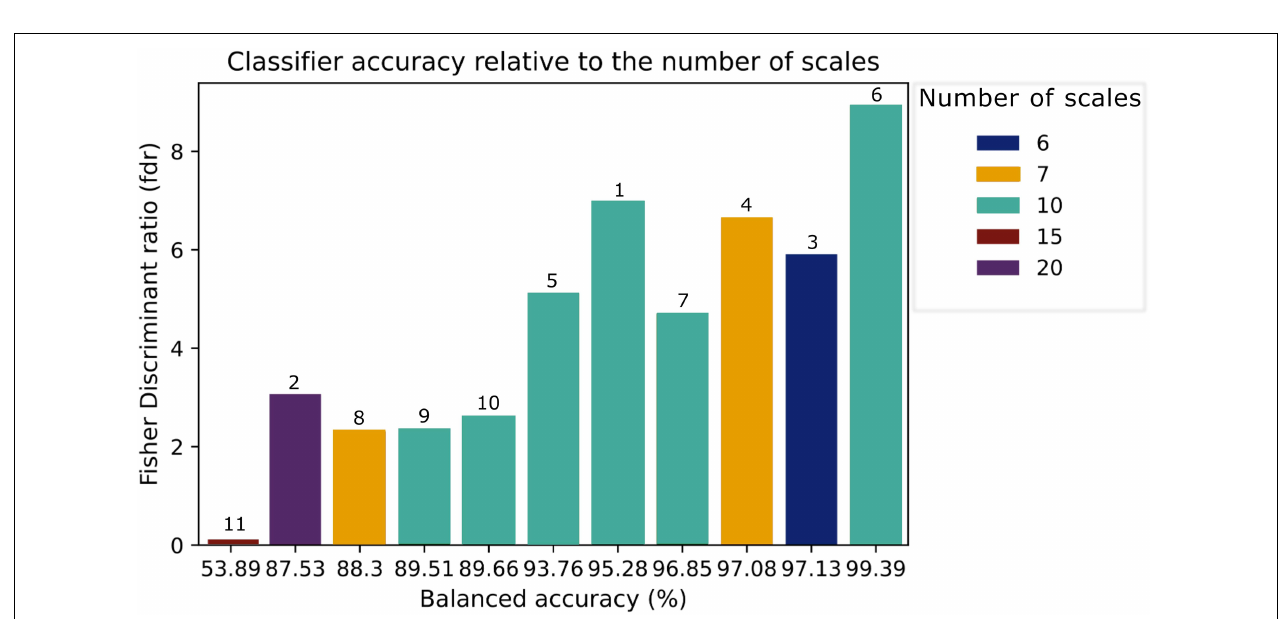
FIGURE 4 | Classifier accuracy in relation to the number of scales. The classifier ID is placed on the top of each bar. In the MGC method, scale is defined as the neighbourhood size of pixels to which the classifiers compute each metrics.